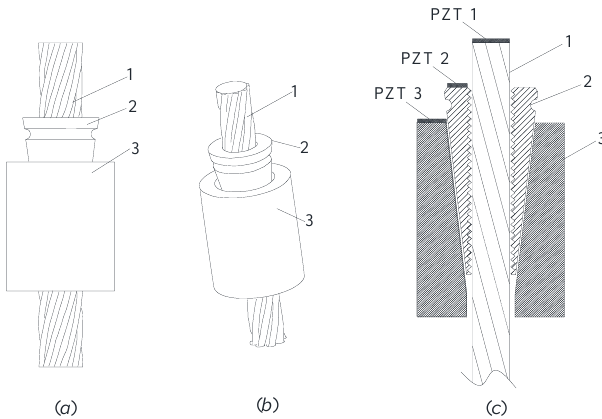
Figure 1. The examined wedge anchorage system and the installation of PZT (Lead Zirconate Titanate) transducers ( a ) 2D view ( b ) 3D view ( c ) cross-sectional view. 1: steel strand; 2: wedge; 3: barrel.